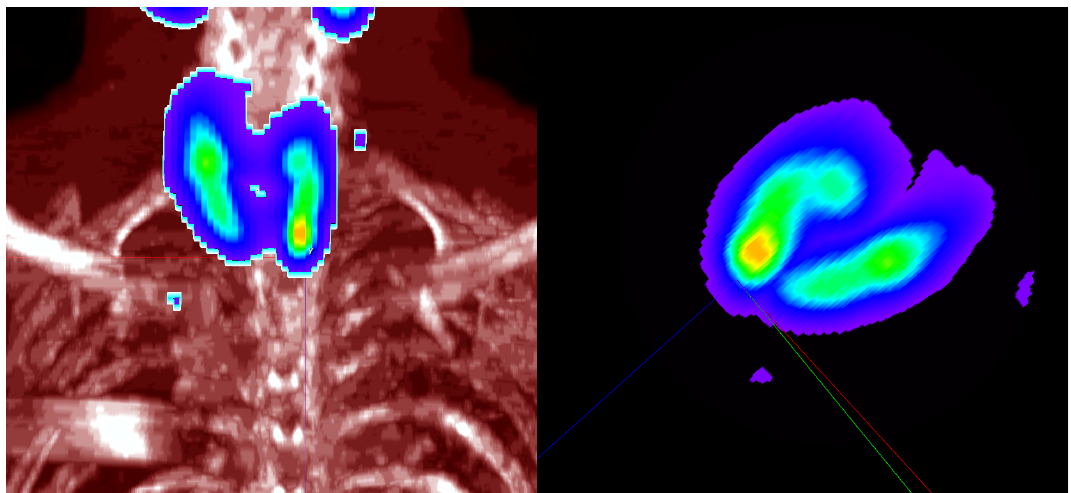
Figure 1. Fusion coronal image of Single-Photon Emission Computed Tomography combined with Computed Tomography (SPECT/CT)—a lesion with slightly increased uptake in a lower left pole of thyroid gland corresponds with abnormal parathyroid gland ( left ). 3D view of parathyroid glands ( right , SPECT only).